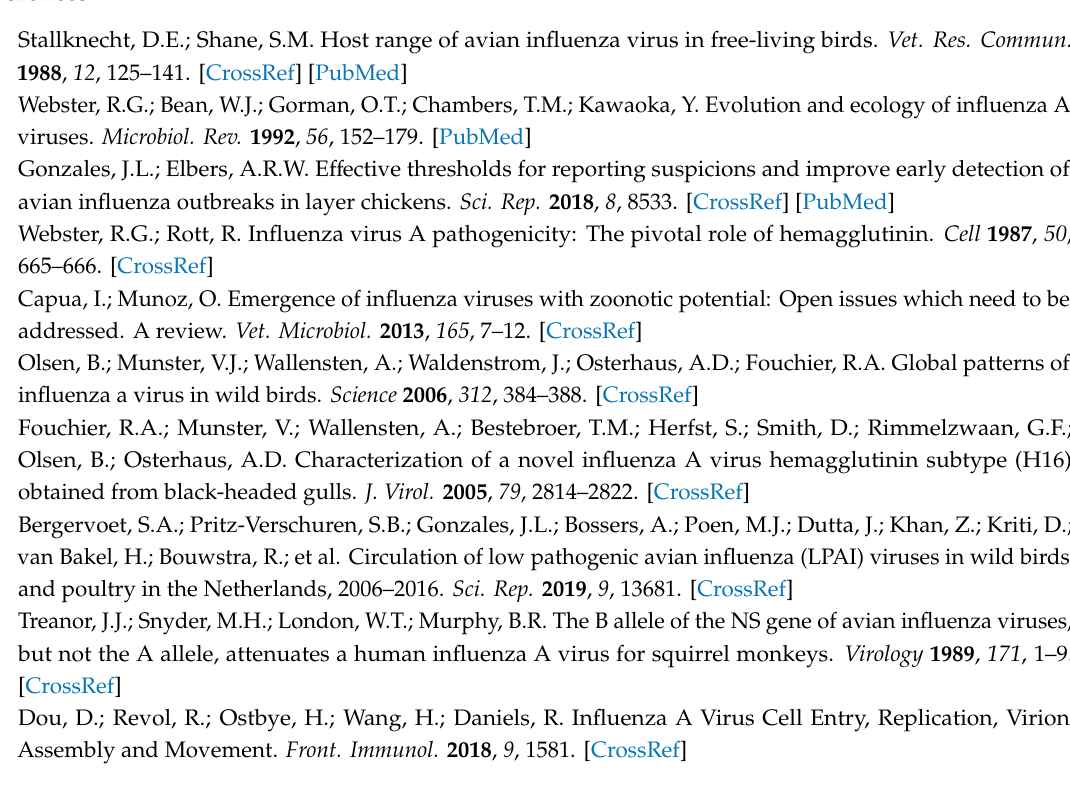
Table S1. Viruses used in the infection experiment. Table S2. Meta-CATS analysis for virus selection. Table S3. Influenza virus–specific antibody detection. Table S4. Oropharyngeal shedding. Table S5. Cloacal